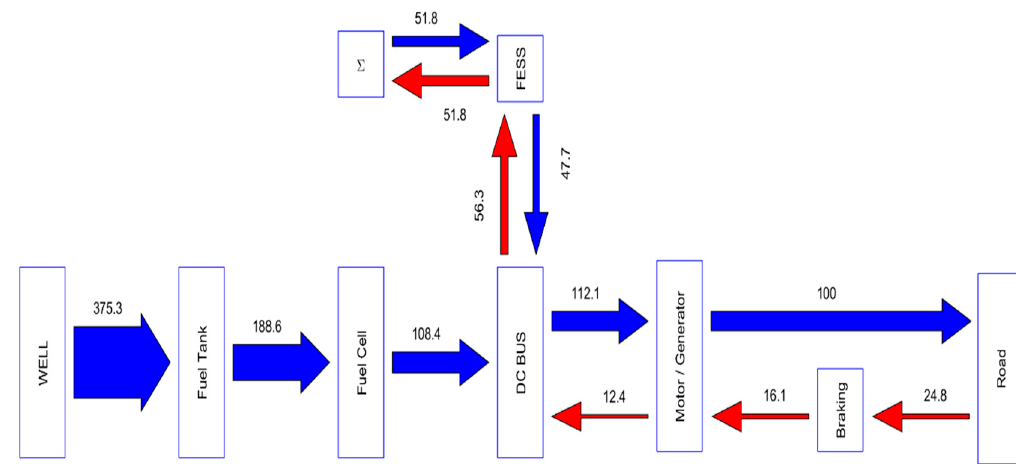
Figure 10. FC stacks partitioning and activation.